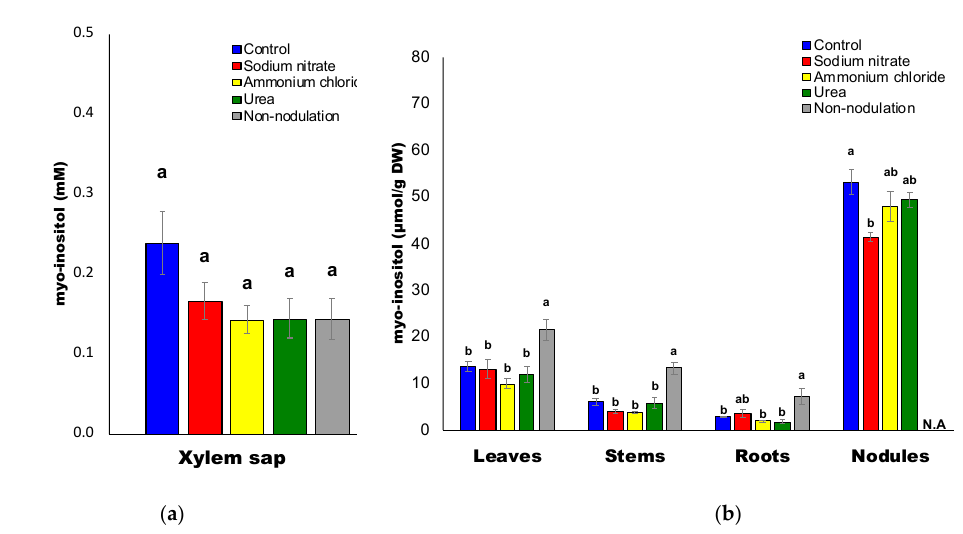
Figure 6. ( A ) Sucrose concentrations in the xylem sap ( a ) and in each part ( b ) of the soybean plant. ( B ) Glucose concentrations in the xylem sap ( a ) and in each part ( b ) of the soybean plant. ( C ) Fructose concentrations in the xylem sap ( a ) and in each part ( b ) of the soybean plant. ( D ) Myo-inositol concentrations in the xylem sap ( a ) and in each part ( b ) of the soybean plant. N.A: not available.